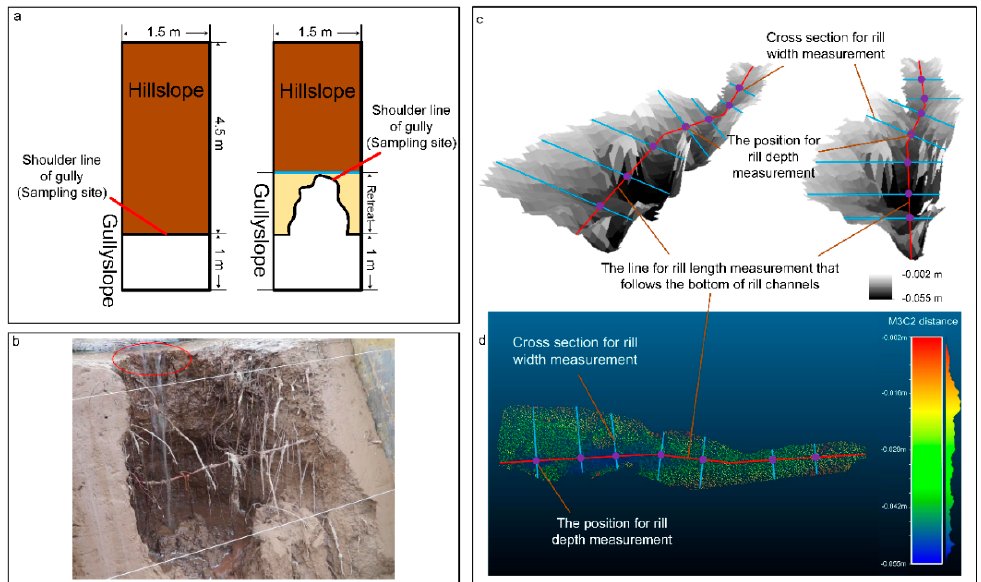
Figure 2. Schematic illustration of the retreat of the hillslopes: ( a ) the development of gullies during the experiments; ( b ) a photo showing the exact position (marked by the red circle) for runoff sample collection; ( c ) digital elevation models (DEMs); and ( d ) corresponding point clouds demonstrating the measurement of rill dimensions.